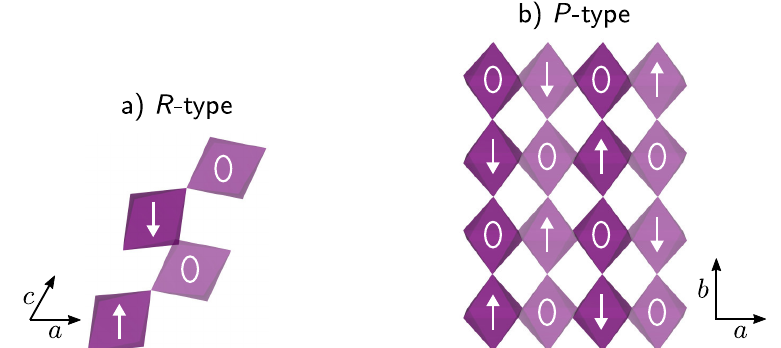
Figure 2: The a) R - and b) P -type phases derived from the R 3 c and Pnma structures with the propagation wave vectors ( 0,0, 1 smallest units of repetition are shown. The octahedra in different layers in the out- of-plane direction are shaded differently. The octahedra with the symbol “0” have smaller volumes, and the Ni sites inside them have no magnetic